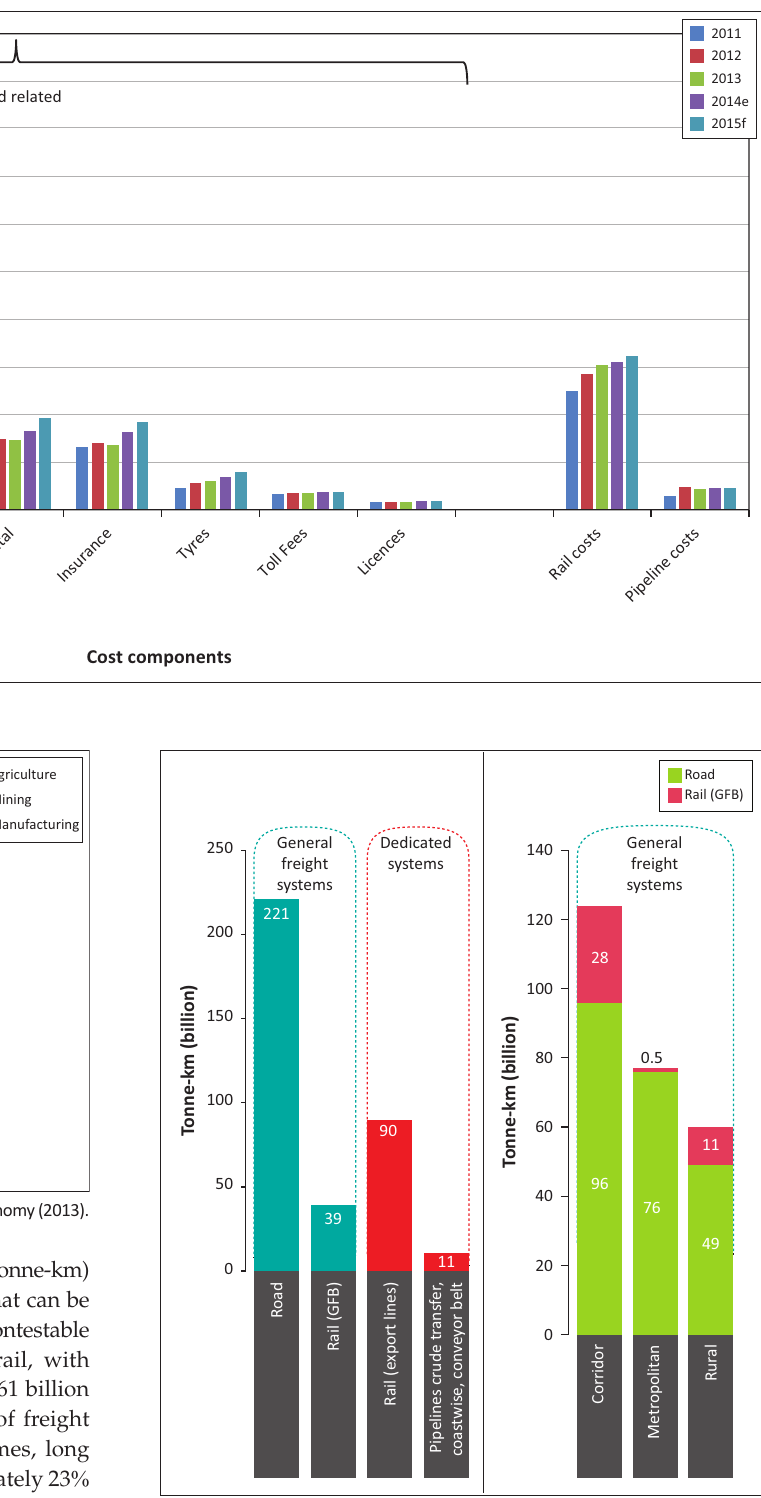
FIGURE 8: Tonne-kilometres by mode and typology